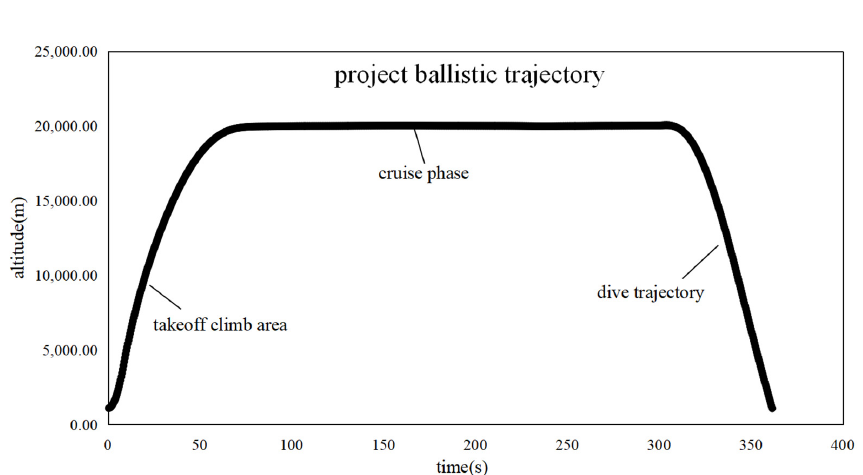
Figure 2. Project ballistic trajectory of a vehicle.